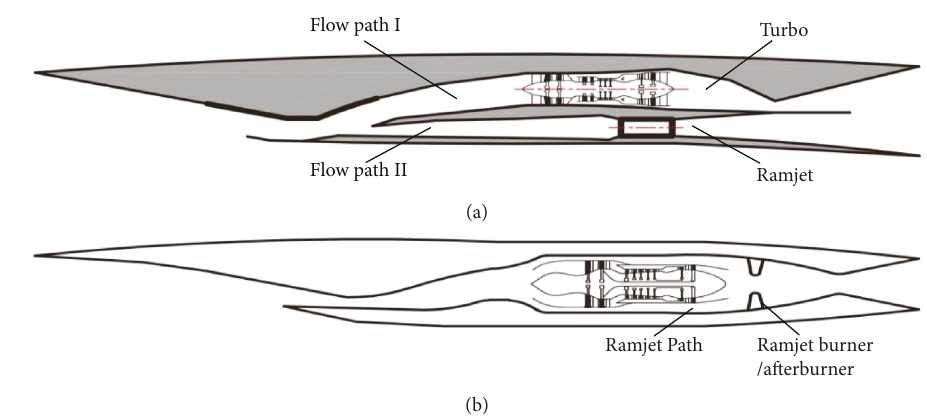
Figure 2: Two typical TBCC engine con fi gurations ((a) parallel type; (b) tandem type).